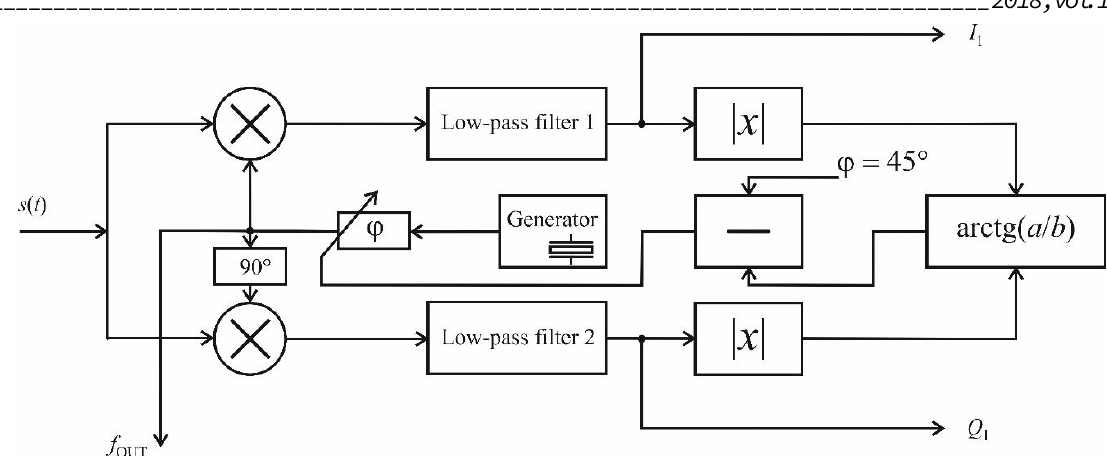
Fig. 6. Structure block diagram of a circuit for carrier frequency recovery for the QPSK signal with an adjustable phase shifter.